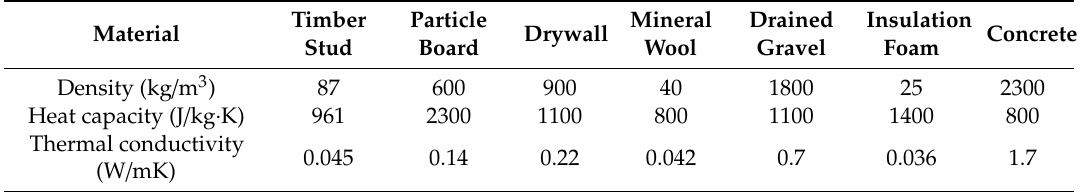
Table 4. Material specification in both BBR and passive building types excluding flooring